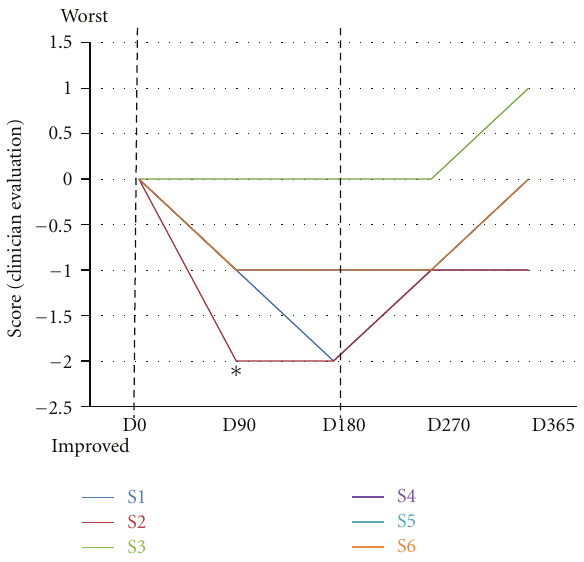
Figure 5: Clinical assessment of IGF1 treatment on